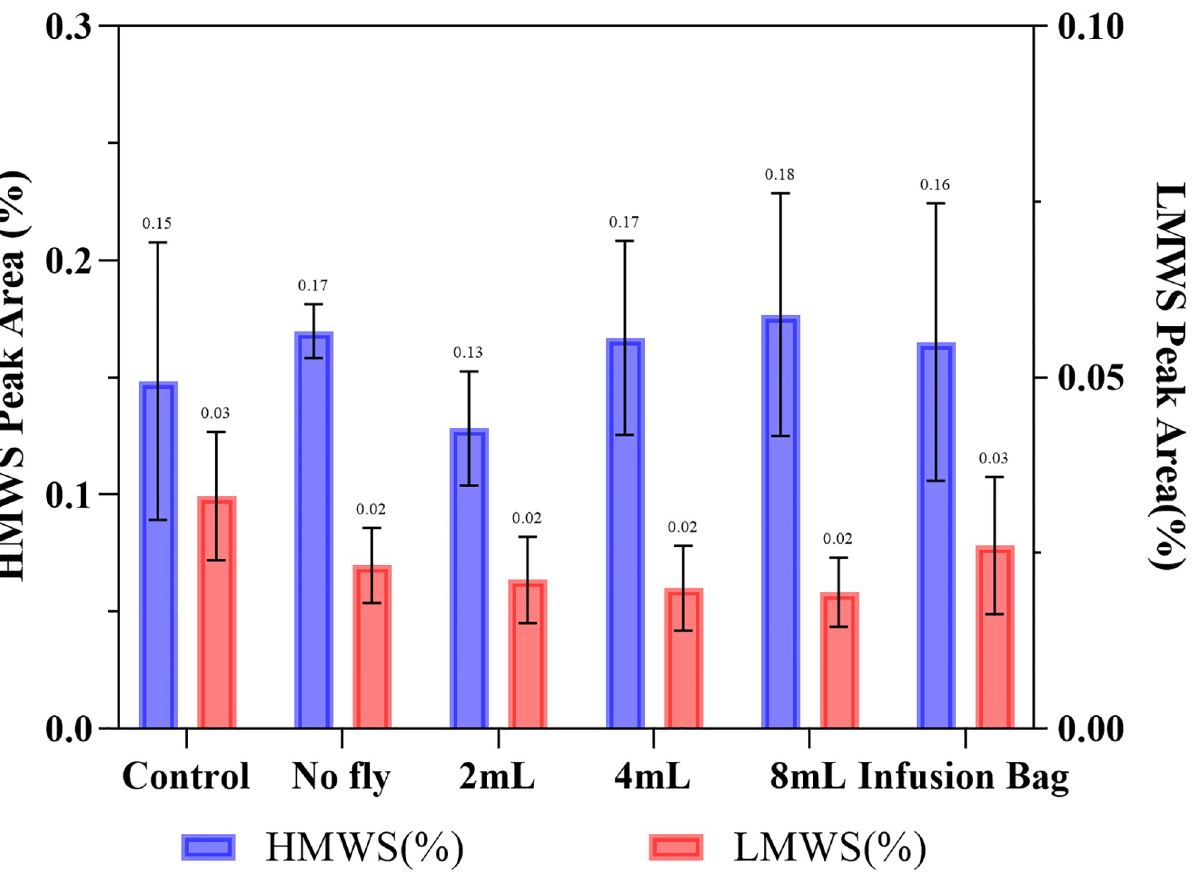
Fig 11. SE-HPLC peak area (%) of Trastuzumab of aggregates (HMWS) and fragments (LMWS) in different storage conditions. Data are shown as mean ± SD (n = 3).